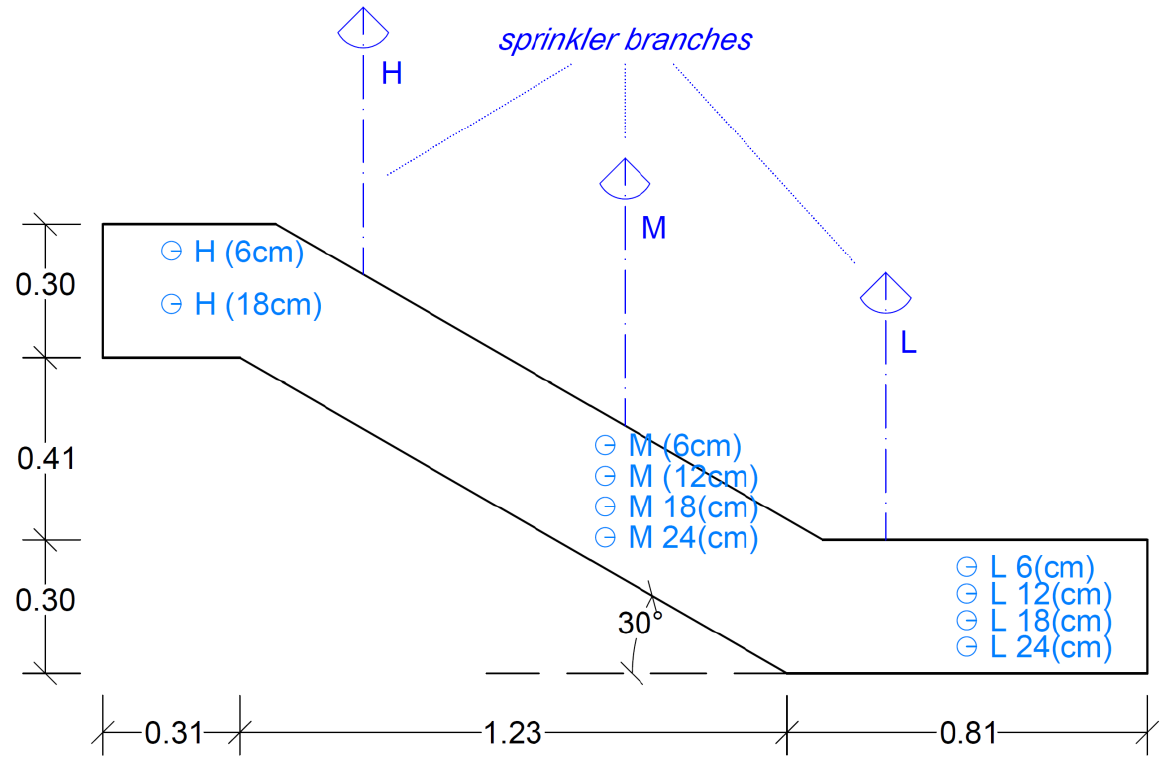
Figure 2. A cross-section of the model with 30° slope (inclination) with the indication of the main geometric characteristics, soil moisture sensors’ positions (blue labels) and sprinkler branches in the upper (H), middle (M) and lower (L) parts of the model. Model dimensions are in meters.